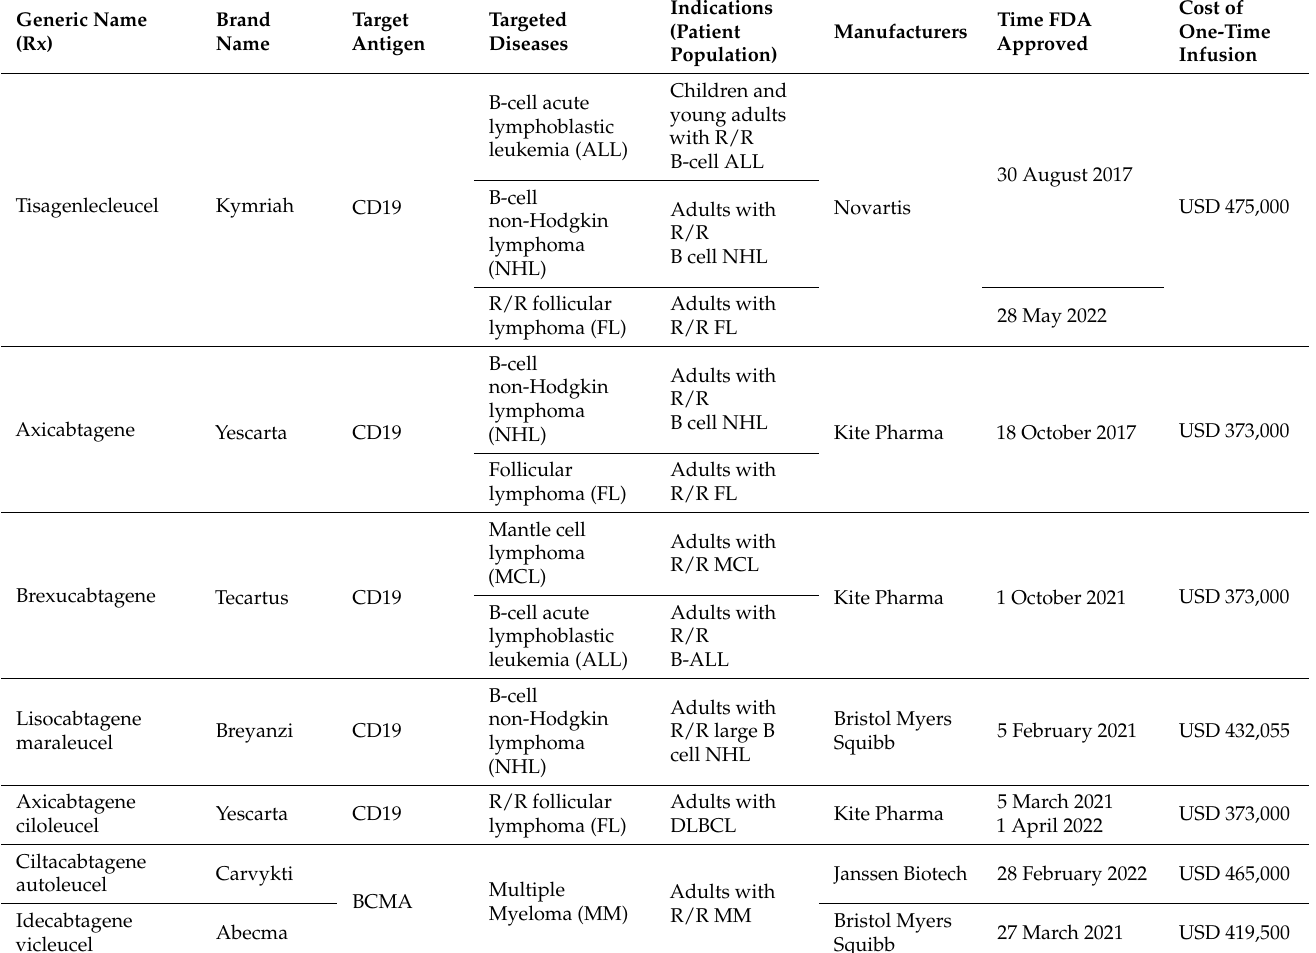
Table 1. FDA-Approved CAR T-cell Therapies in hematological